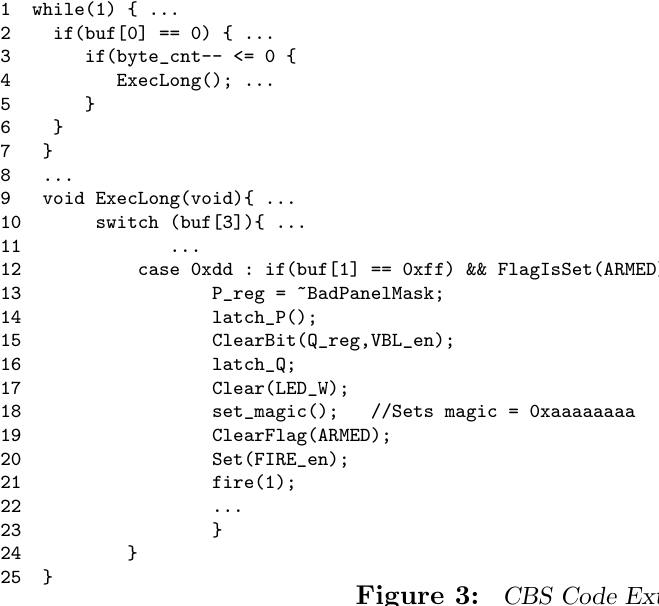
Figure 3: CBS Code